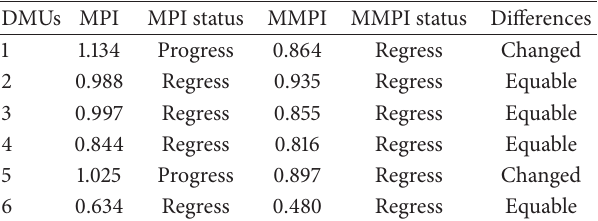
Table 9: Malmquist Productivity Index.